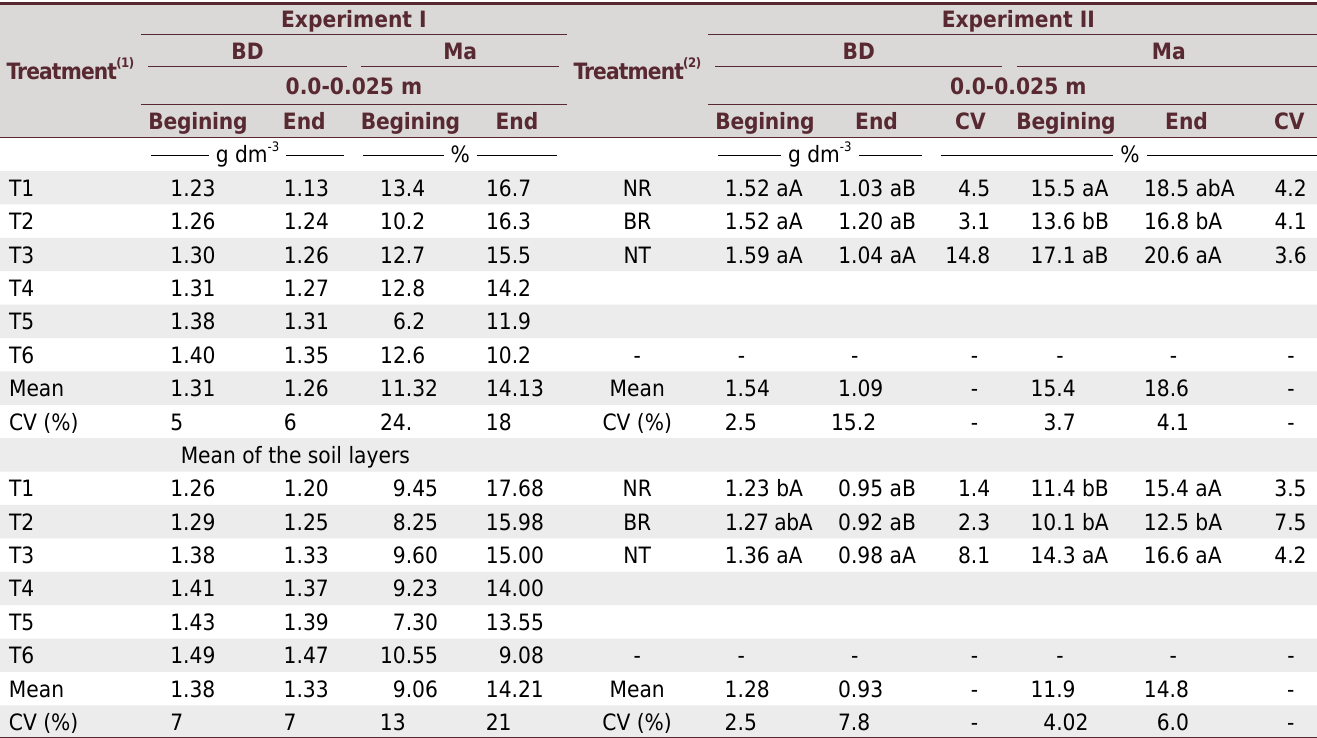
Table 3. Soil bulk density (BD) and macroporosity (Ma), at the beginning and end of the study, determined in the treatments (Treat) of experiments I and II, in the 0.0-0.025 m layer and in the mean of the 0.0-0.025, 0.025-0.05, 0.05-0.10, and 0.10-0.20 m layers